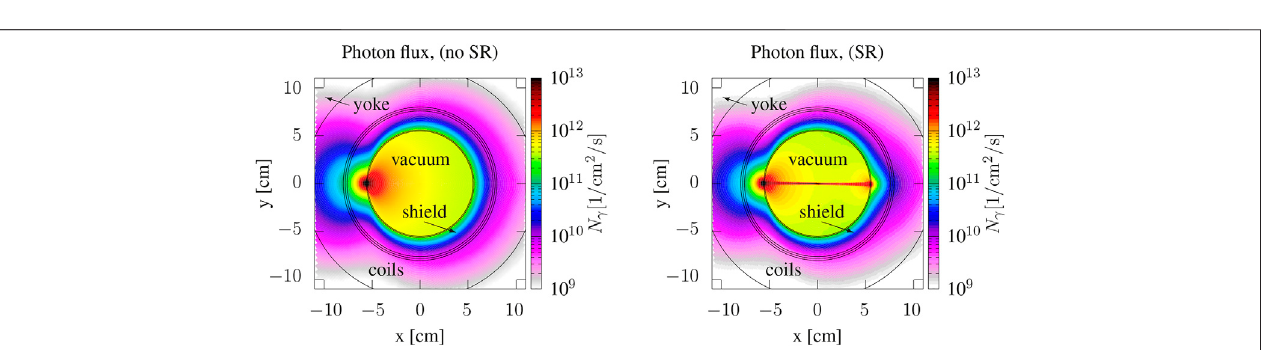
FIGURE 6 | Photon fl ux distribution in the 10.2 T bending dipole of a 4.5 km ring accomodating a 1.5 TeV negative muon beam with a bunch intensity of 2 × 10 12 particles(transversesection).Bunchesareinjectedwitha12 Hzfrequency.Sychrotronradiationemittedbyhighenergyelectronsgeneratedbymuondecayisneglected on the left and accounted for on the